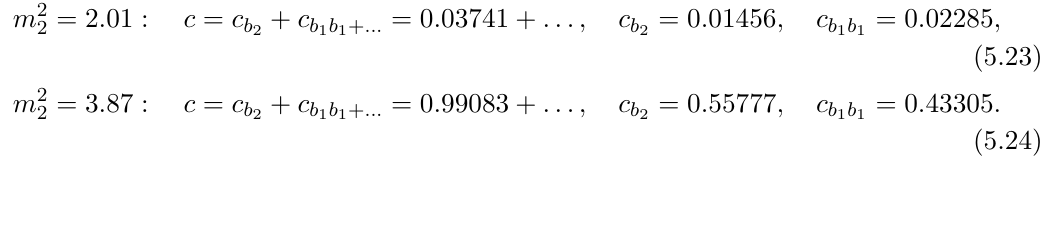
= 4 approaches 1, 2 = 2 : 01 and m 2 = 3 : 87. We 2 2